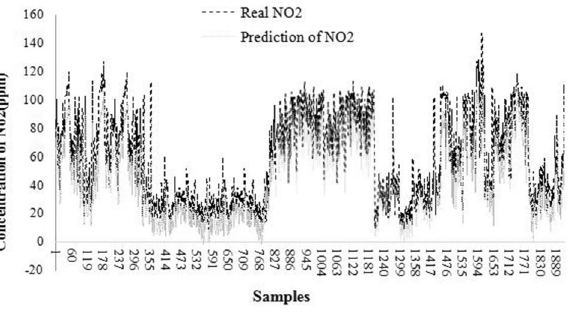
Figure 1. The result of stepwise-multi linear regression in forecasting ting the NO 2 concentration of